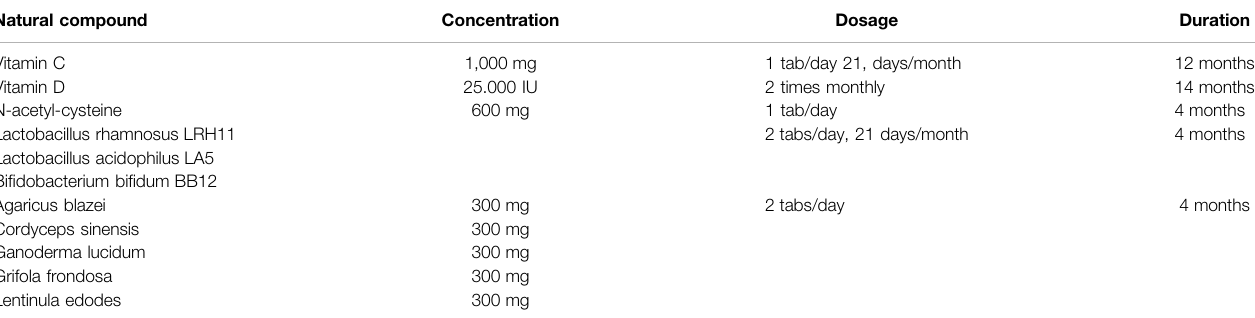
TABLE 4 | Support treatment administered as IM approach. Natural compound Vitamin